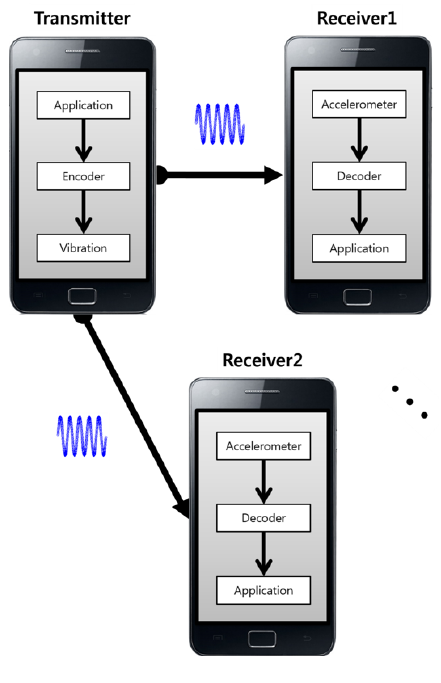
An overview of VibeComm . A transmitter encodes a message into a series of vibrations. Vibrations propagate through the object on which the transmitter is placed. Receivers that are placed on the same object listen for incoming vibrations using accelerometers and decode them into